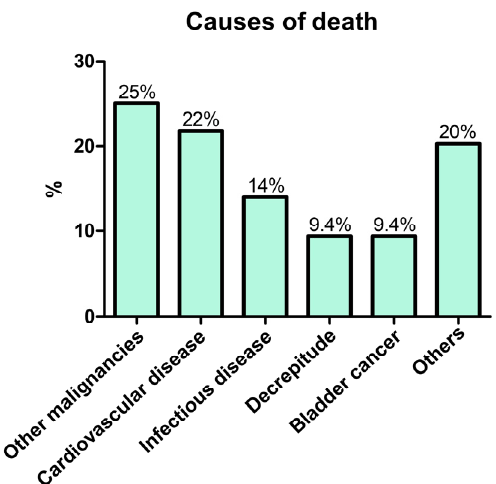
Figure 3. Causes of death after a 5-year cancer-free period. The OS in patients with lower PMI values was significantly shorter than that in pa- tients with higher PMI values (Figure 4A, p = 0.003). The OS in patients with higher IMAC values was significantly shorter than that in patients with lower IMAC values (Figure 4B, p = 0.025). The OS in the severe sarcopenia group was significantly shorter than that in the control group (Figure 4C, p < 0.001).